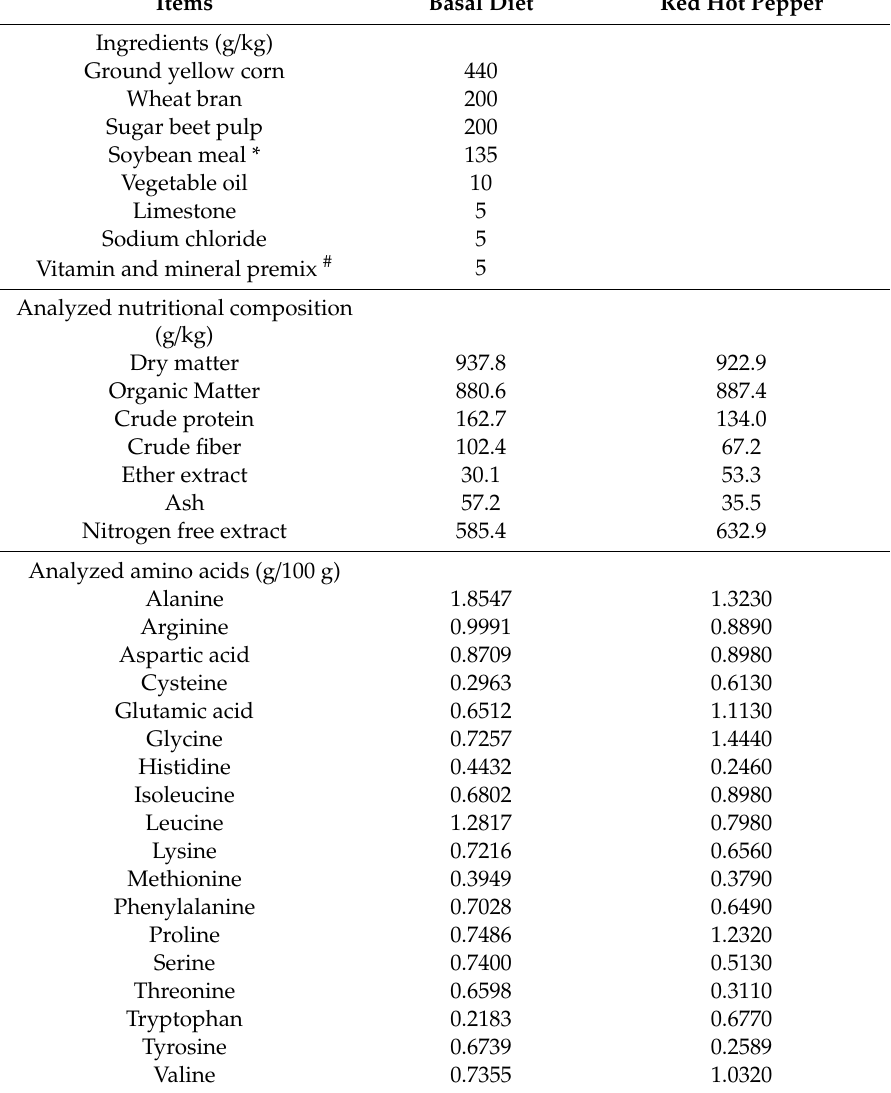
Table 1. Ingredients, analyzed nutritional composition and amino acids of basal diet and red-hot pepper.